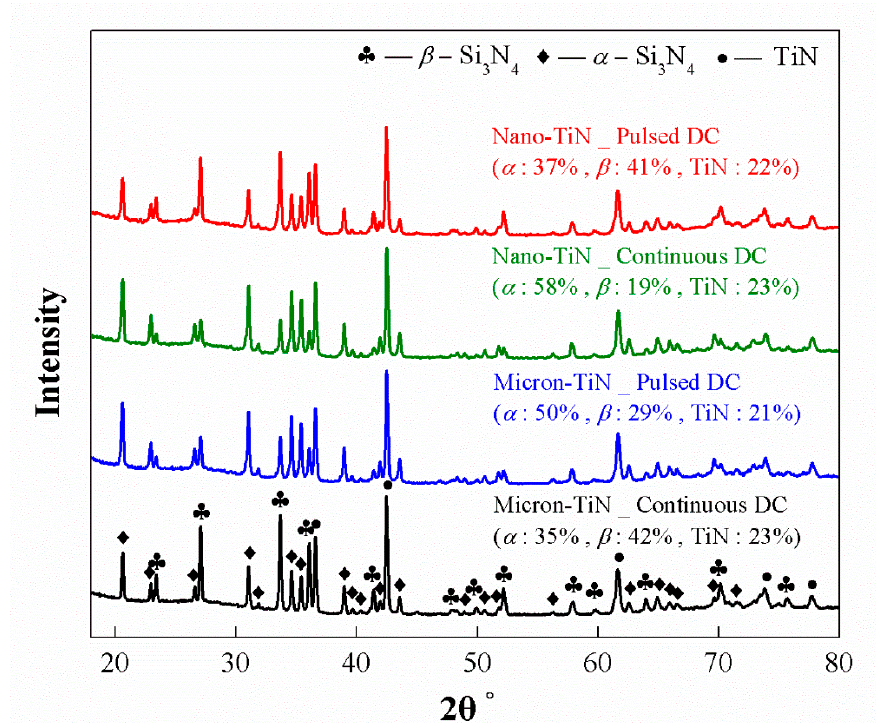
Figure 6. XRD patterns with qualitative and quantitative analysis of Si 3 N 4 -20 vol % TiN samples with micron- or nano-TiN particles, respectively sintered under continuous current mode and pulsed mode at 1800 °C for 30 s.